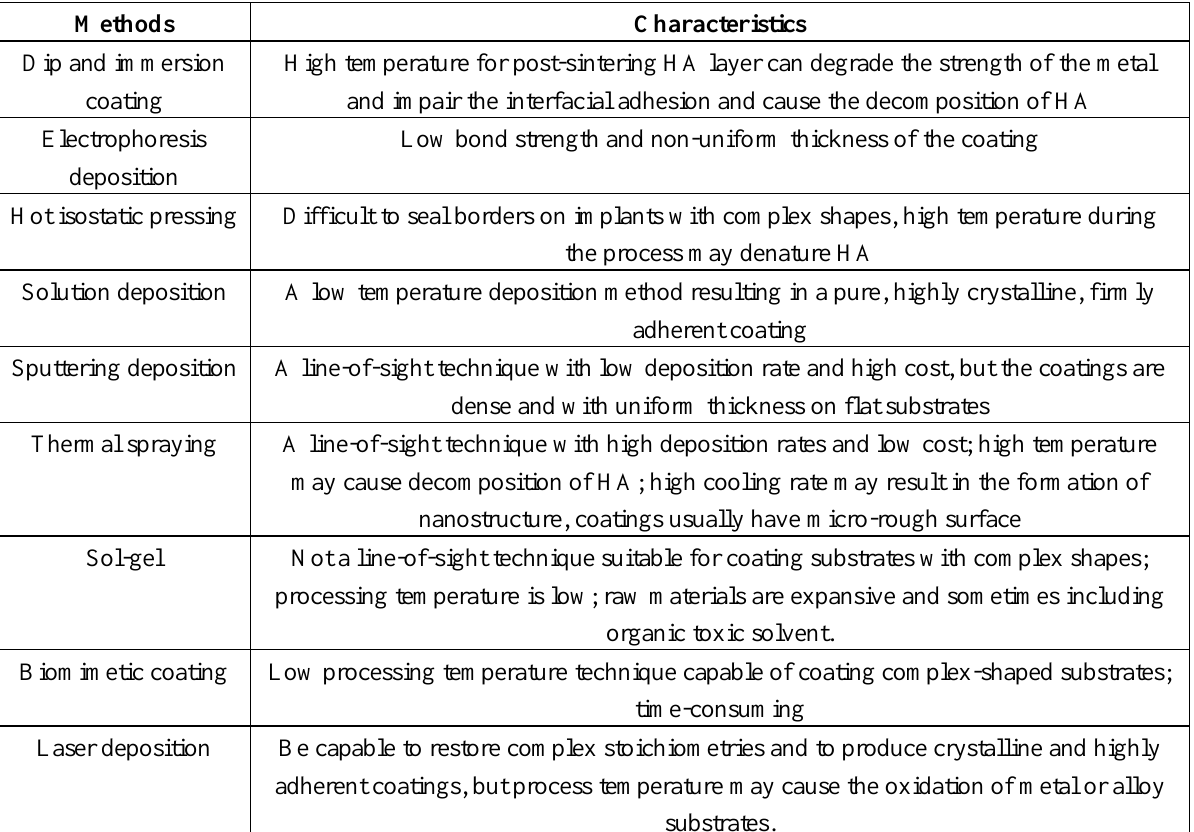
Table 4. Summary of surface techniques for depositing Ca & P coatings on metal implants and their